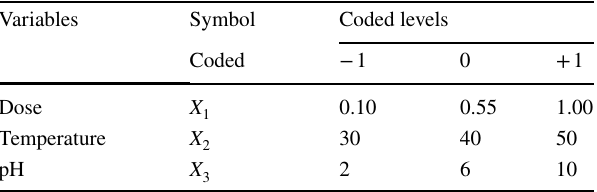
Table 1 Levels and codes of selected variables for Box–Behnken design Variables